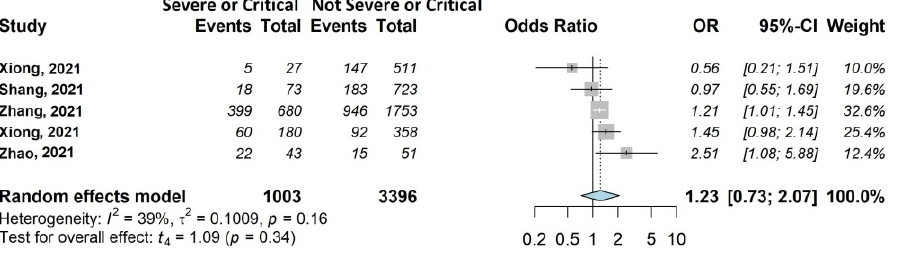
Figure 7. Forest plots of adjusted analyses for association between acute disease severity and fatigue. HKSJ, Hartung-Knapp-Sidik-Jonkman.